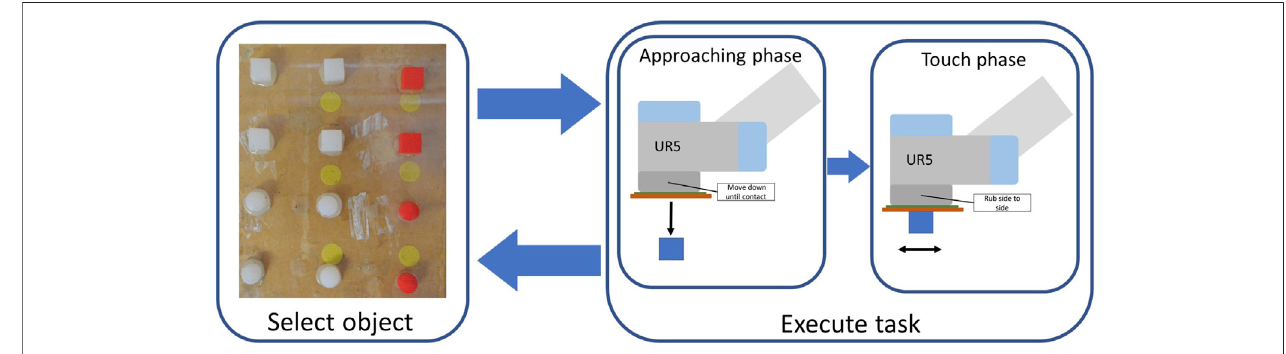
FIGURE 4 | Work- fl ow of asingle trial during data collection. First, the object of interest is selected among the twelvepossible options: four combinations ofshape and roughness for each of the three levels of stiffness. Next, the approaching and touch phases are performed on the object of interest.